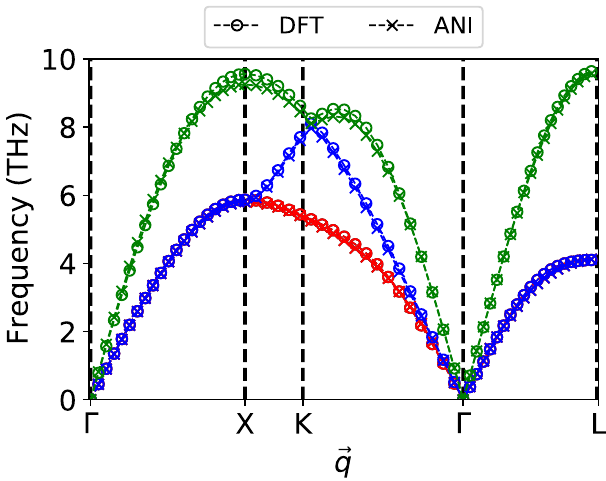
Fig. 3 Comparison of predicted vs. reference phonon spectrum. Phonon spectrum of FCC Al predicted by the ANI-Al model (crosses) and compared to the DFT reference (circles).